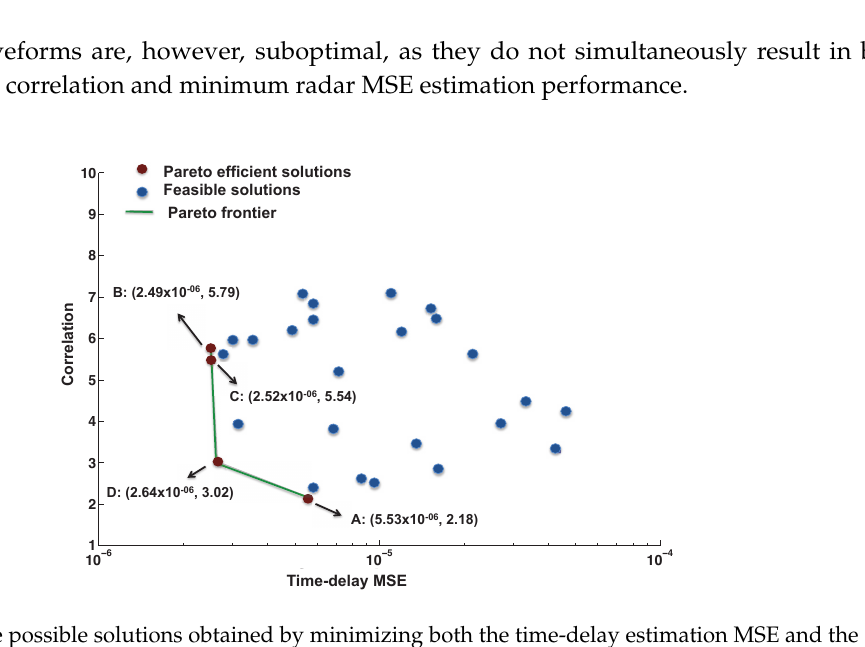
Figure 10. The possible solutions obtained by minimizing both the time-delay estimation MSE and the system correlation are shown in blue; the efficient Pareto solutions (shown in maroon) are connected (using green) with the Pareto frontier.